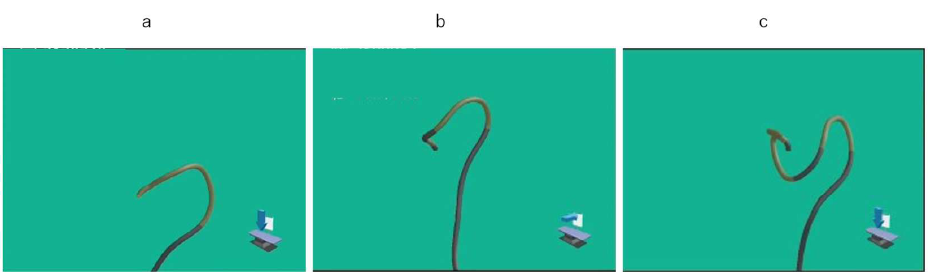
Figure 3. Endoscopic position detection unit (UPD) graphic image of patterns for passing through the hepatic flexure: ( a ) suction of air and right rotation procedure; ( b ) operation with positional change; ( c ) operation with push